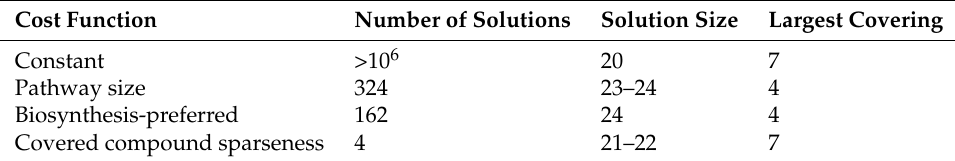
Table 3. Summary of ST000061 Coverings by Cost